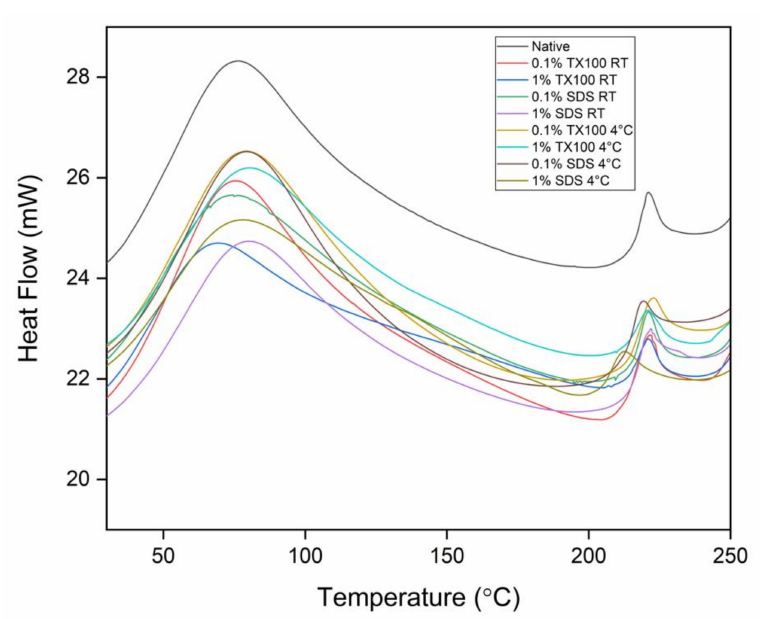
Figure 6. Differential Scanning Calorimetry (DSC) analysis of the native and decellularized ECM from milkfish